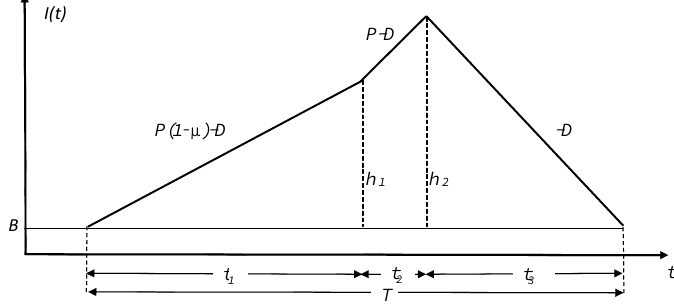
Figure 4. Economic production Quantity model with variable defective rate and